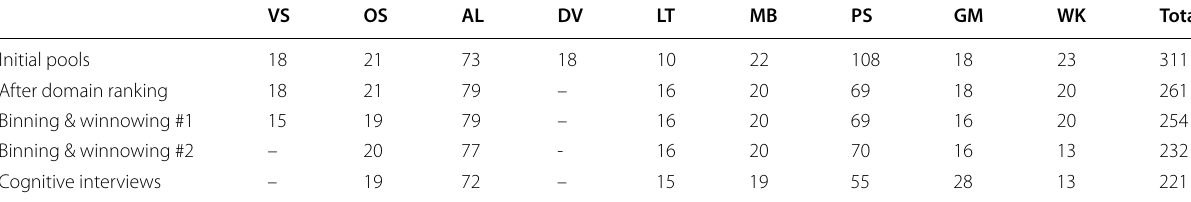
Table 4 The process of refining the initial item pools to the final pilot instrument (Phase